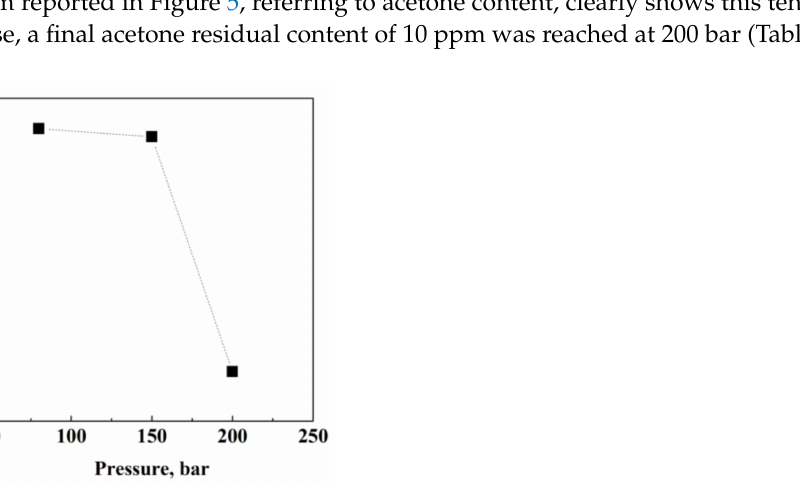
Figure 5. Acetone residual concentration in Fluti after SC-CO 2 extraction performed at different operative pressures and at 40 ◦ C and 0.7 kg/h CO 2 flow rate.